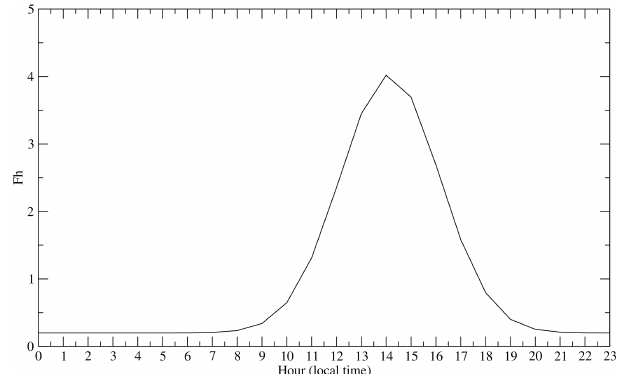
Figure 11. Academic hourly profile applied to the constant daily wildfire fluxes.